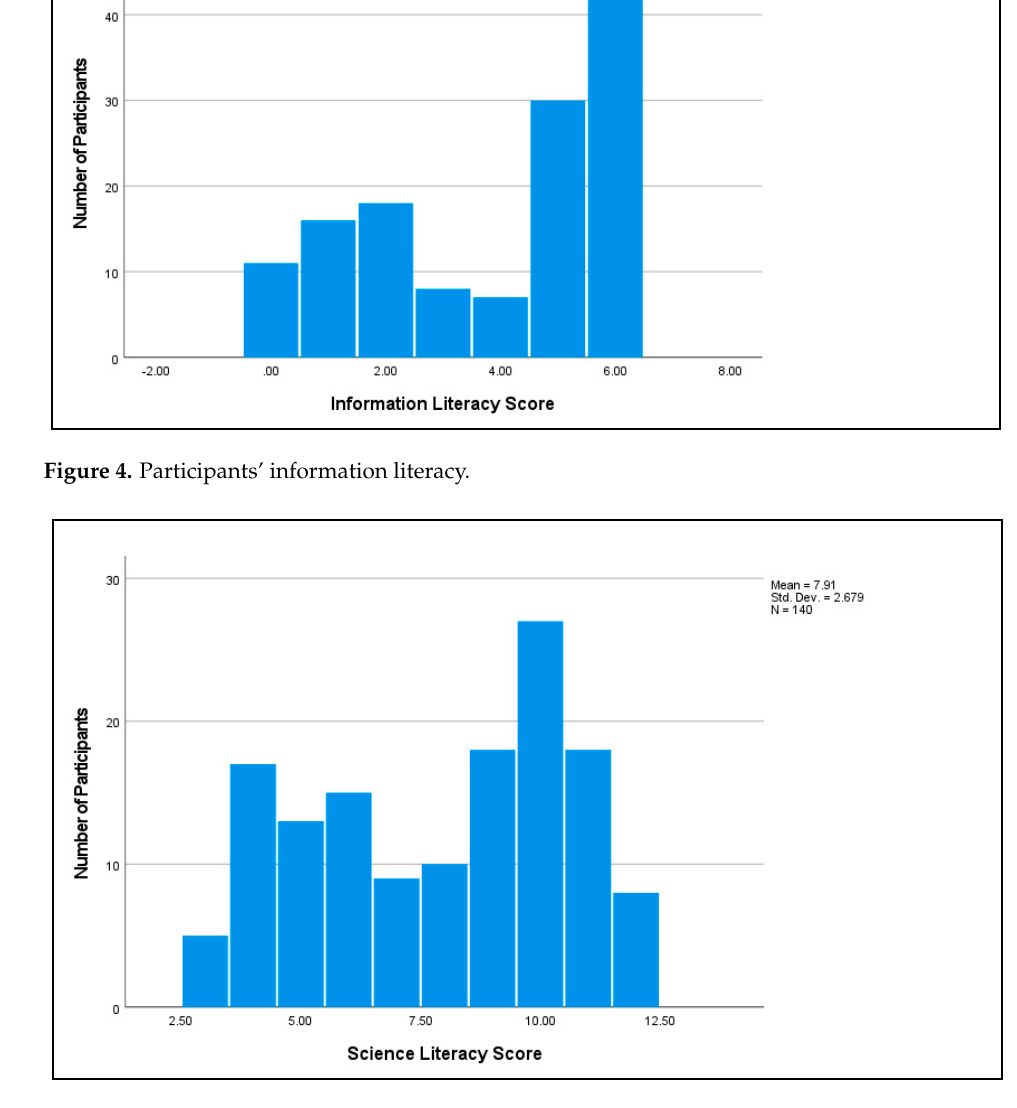
Figure 5. Participants’ science literacy.